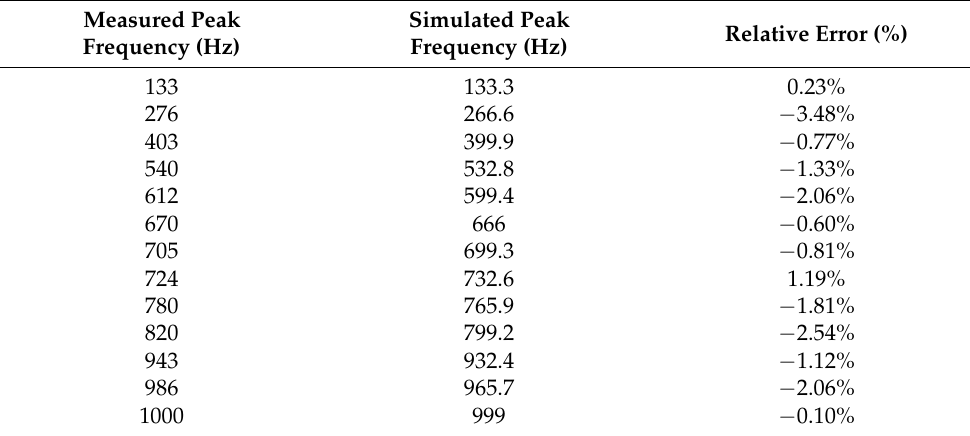
Figure 7. Normalized acceleration and peak frequencies of the measured point. Table 2. Comparison of the peak frequencies of measured and simulated